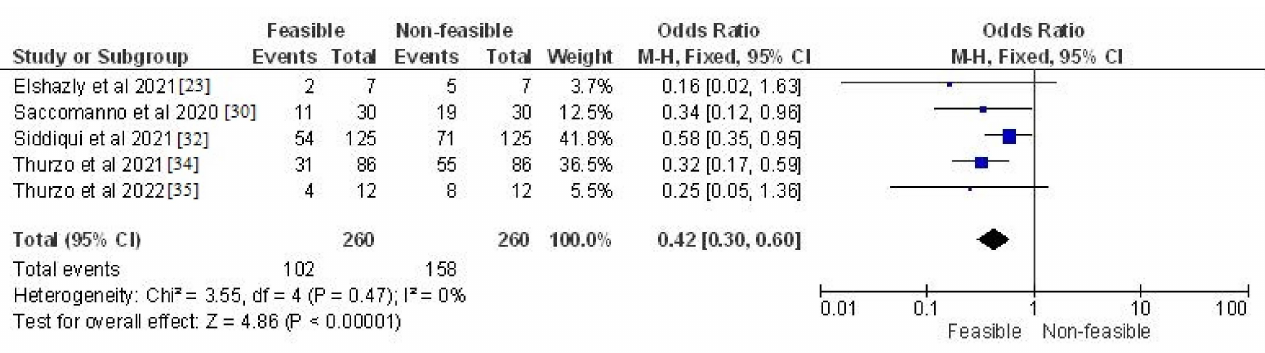
Figure 2. Odds ratio of in-vitro, observational and cohort-based studies selected in this systematic review which assessed the feasibility vs. non-feasibility rates of their respective trends represented on a forest plot after meta-analysis